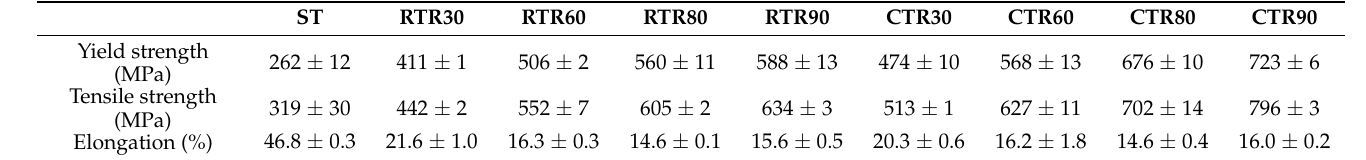
Table 3. Mechanical properties of the Cu-Ti-Cr-Mg alloy after different rolling